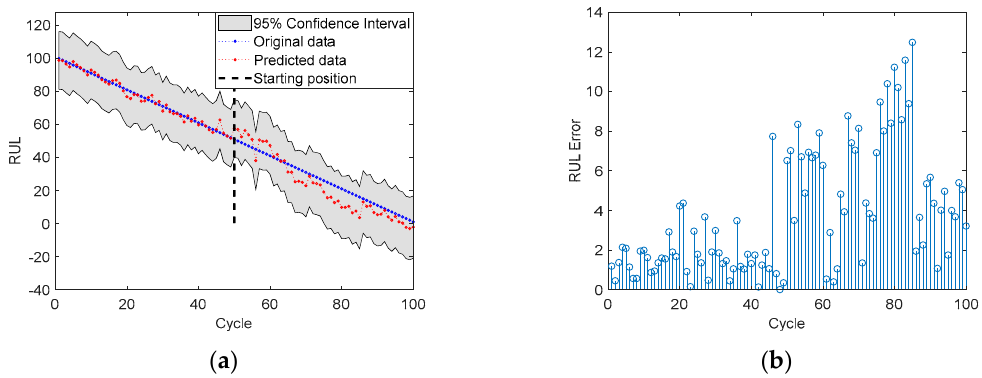
Figure 13. RUL prediction results for battery No. 18 with SP = 51: ( a ) RUL; ( b ) RUL prediction Error.